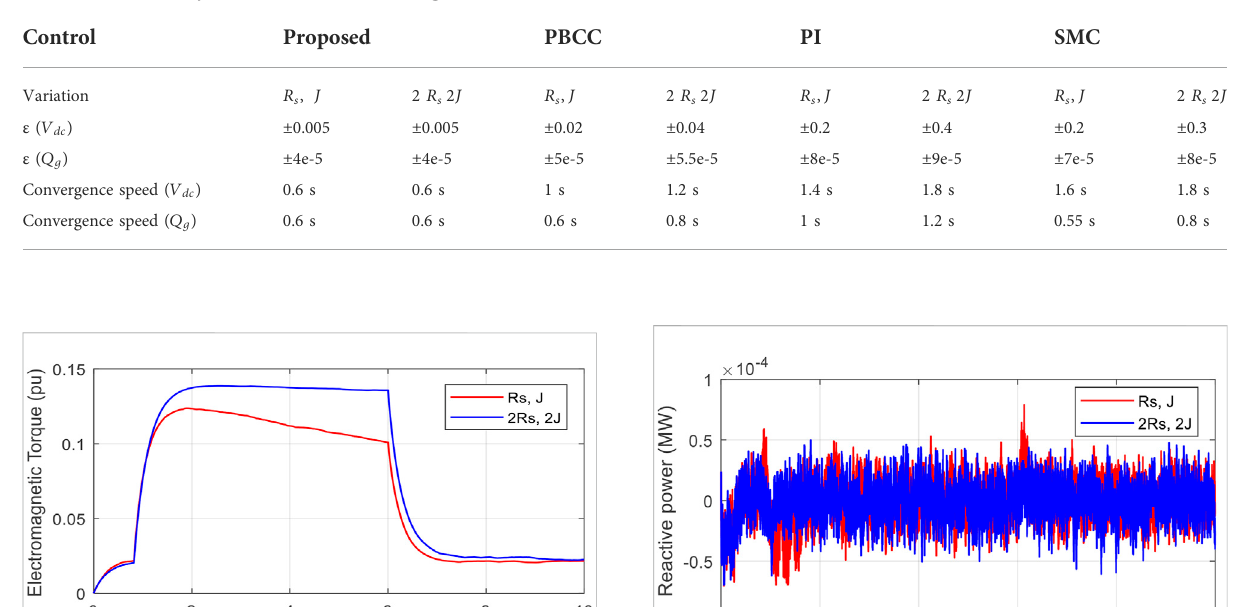
TABLE 3 Results comparison of the control strategies.